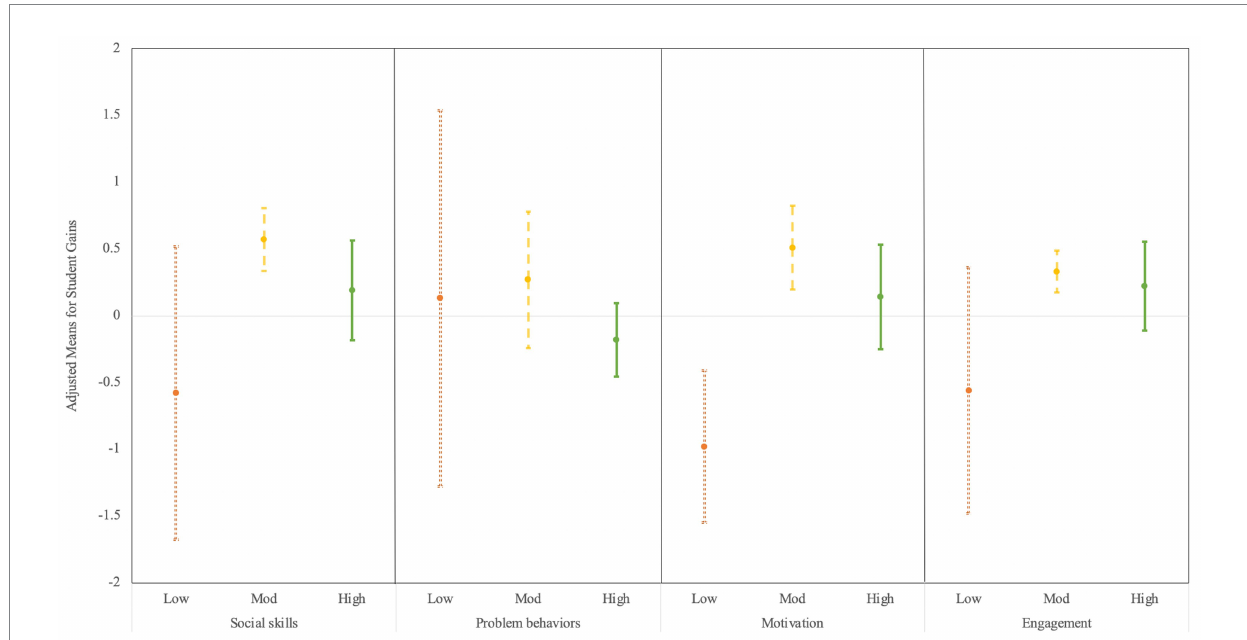
FIGURE 2 Auxiliary regression estimates of student gains with 95% CIs by Profile. Low, Low implementation profile; Mod, moderate implementation profile; High, high implementation profile. Mean outcomes are adjusted for grade, teaching experience (yrs), percentage of students eligible for free/reduced-price lunch (% SFR), classroom organization (CO), instructional support (IS), and percentage of students receiving supplemental education service (%